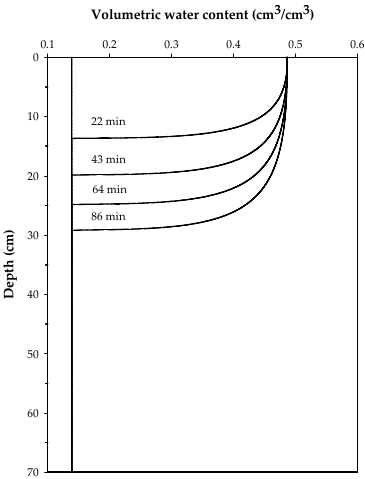
Figure 3. Water infiltration during the first irrigation in sandy loam soil in Montecillo, Mexico.